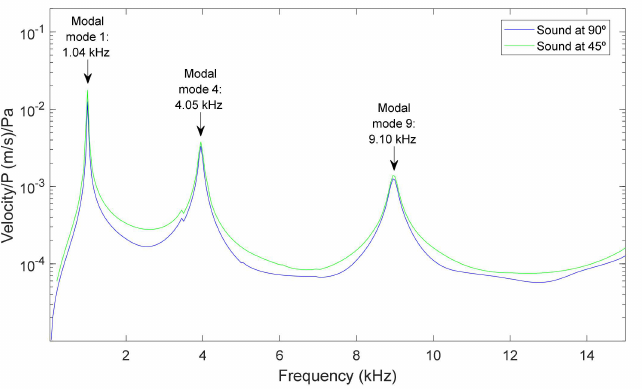
Figure 3. Center point of a membrane of 40 µ m. Velocity magnitude at different positions of the source: (a) 90 ◦ and (b) 45 ◦ .